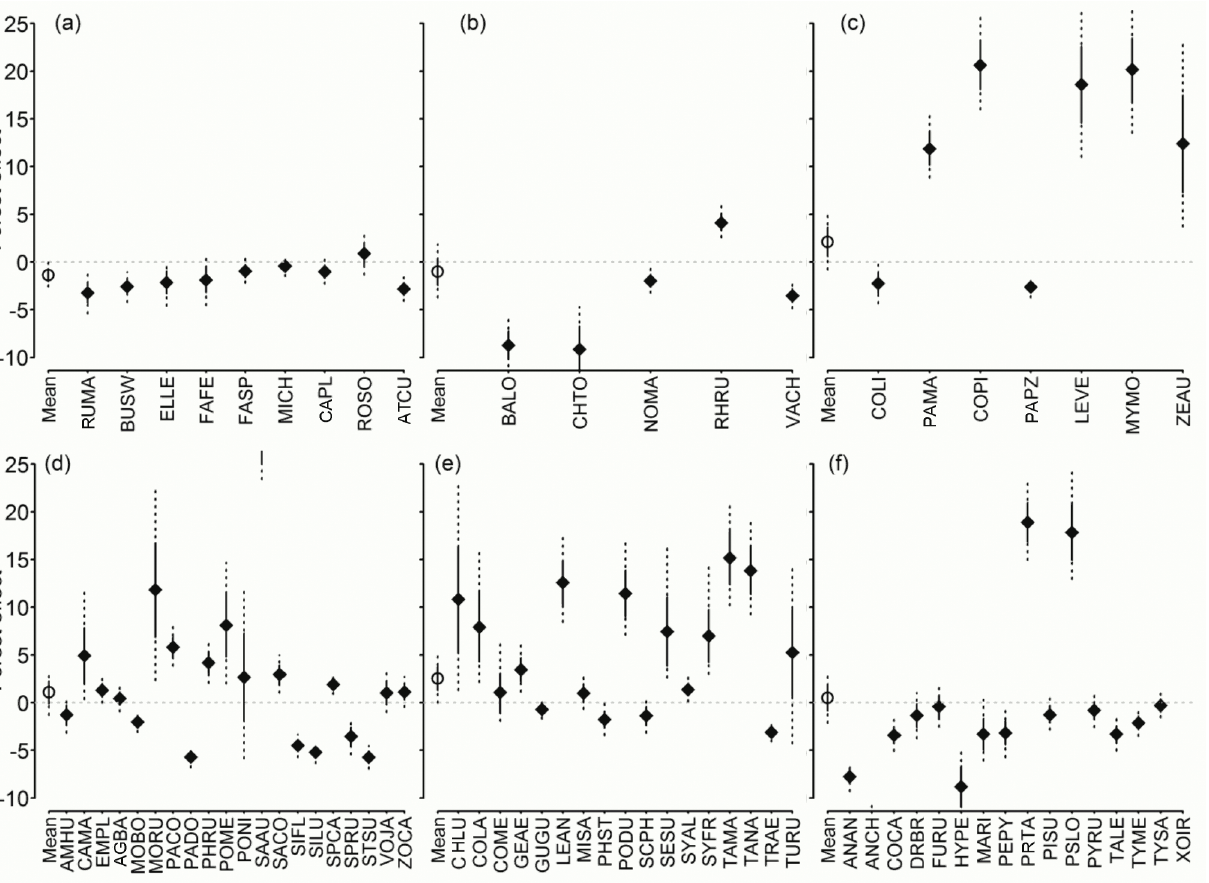
^ β ± Fig 7. Native forest coefficients in the logit scale ( SD, 95% BCI) on logit occupancy (logit ^ ψ ) of each bird species in the regional bird monitoring program in Argentina, 2003 – 2012. (a) Raptors; (b) ground omnivores and herbivores; (c) ground granivores; (d) other granivores; (e) insectivores mostly associated with folliage; (f) other insectivores. For details of species names and guilds, see S1 Table.